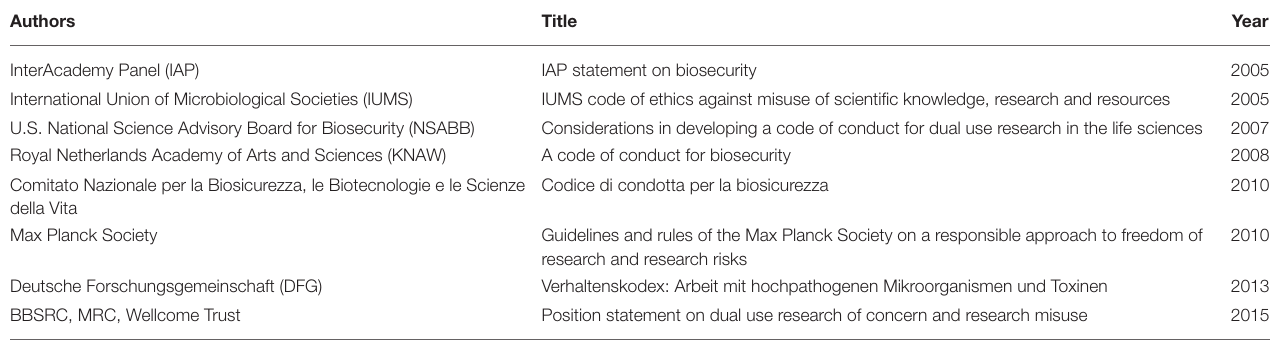
TABLE 1 | Selection of guidance documents and codes addressing the misuse potential of biological